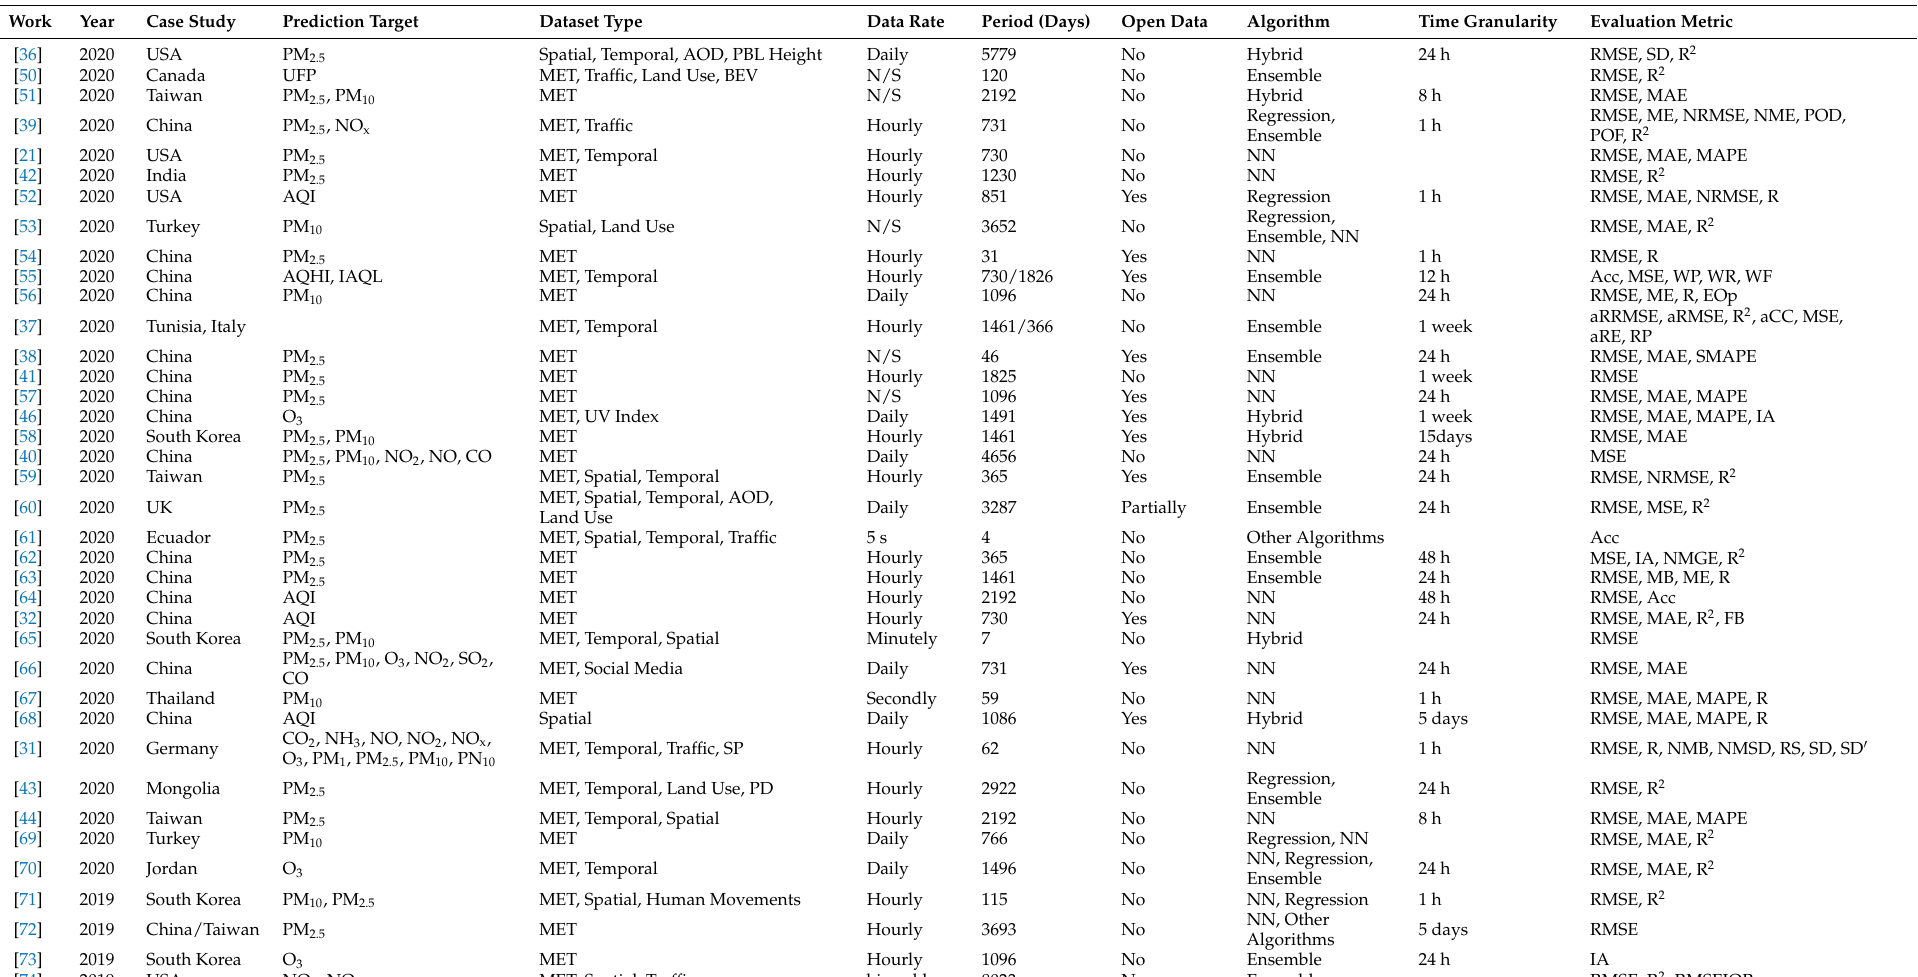
Table A1. Features of the selected papers. N / S : Not Specified. Published in Zenodo with this following doi: https://doi.org/10.5281/zenodo.4302469 [49]. (accessed on 27 February